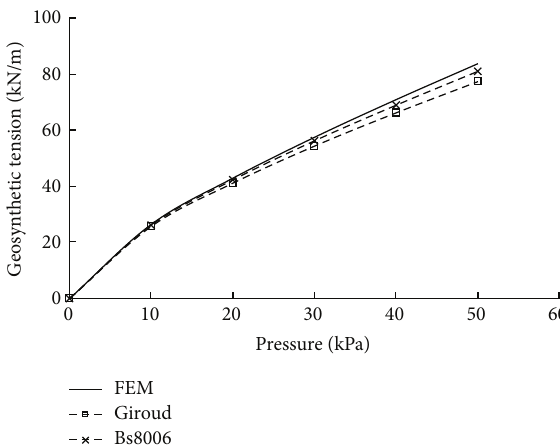
Figure 3: Comparison of geosynthetic deflections computed by 2D FEM and design methods ( 𝑝 = 50 kPa, 2D). Figure 4: Comparison of geosynthetic tensions computed by 2D FEM and design methods